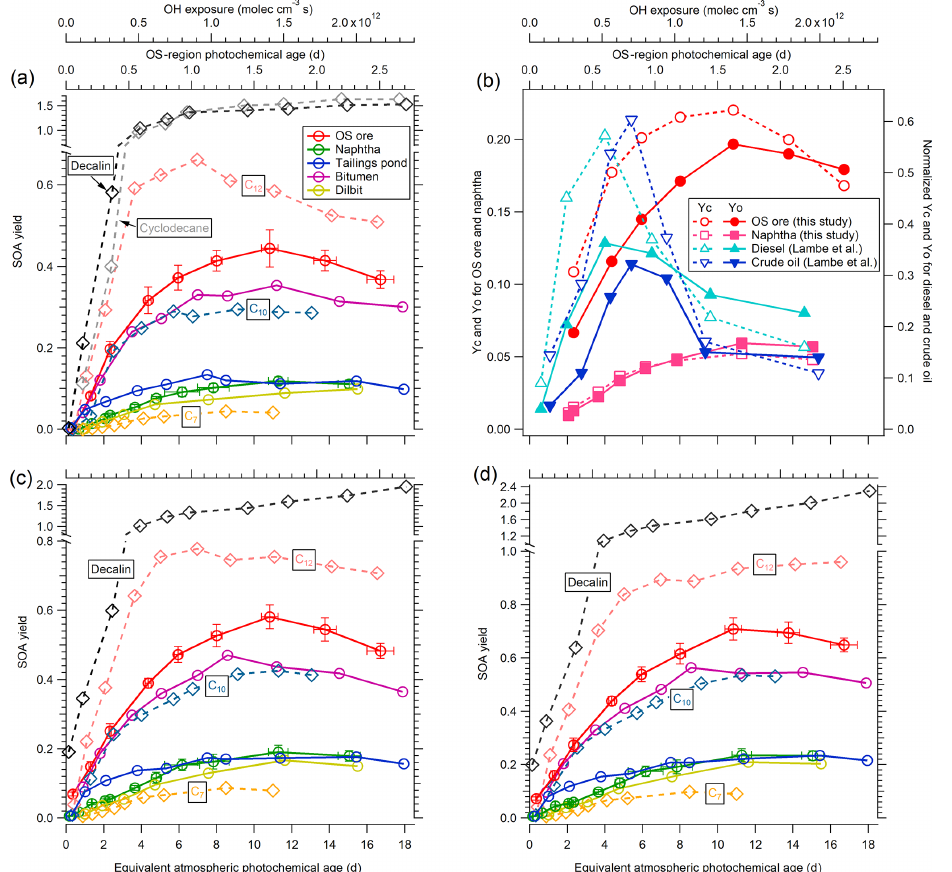
Figure 5. (a) SOA yields of OS-related precursors (OS ore, naphtha, tailings pond water, bitumen, and dilbit) for unseeded experiments as a function of equivalent photochemical age and OH exposure. SOA yields of C 7 , C 10 , and C 12 n -alkanes; cyclodecane; and decalin are also shown for comparison. Representative error bars indicate ± 1 σ uncertainty in measurements. (b) SOA carbon and oxygen yields ( Y C and Y O ) for the OS precursors of lowest and highest volatility (OS ore and naphtha solvent) compared to normalized Y C and Y O for diesel and crude oil (Lambe et al., 2012). (c) SOA yields as in (a) in the presence of ammonium sulfate seed particles. (d) LVOC-fate-corrected SOA yields of OS-related precursors and alkanes for seeded experiments. Note that the y axis ranges are different in (a) , (c) , and (d)